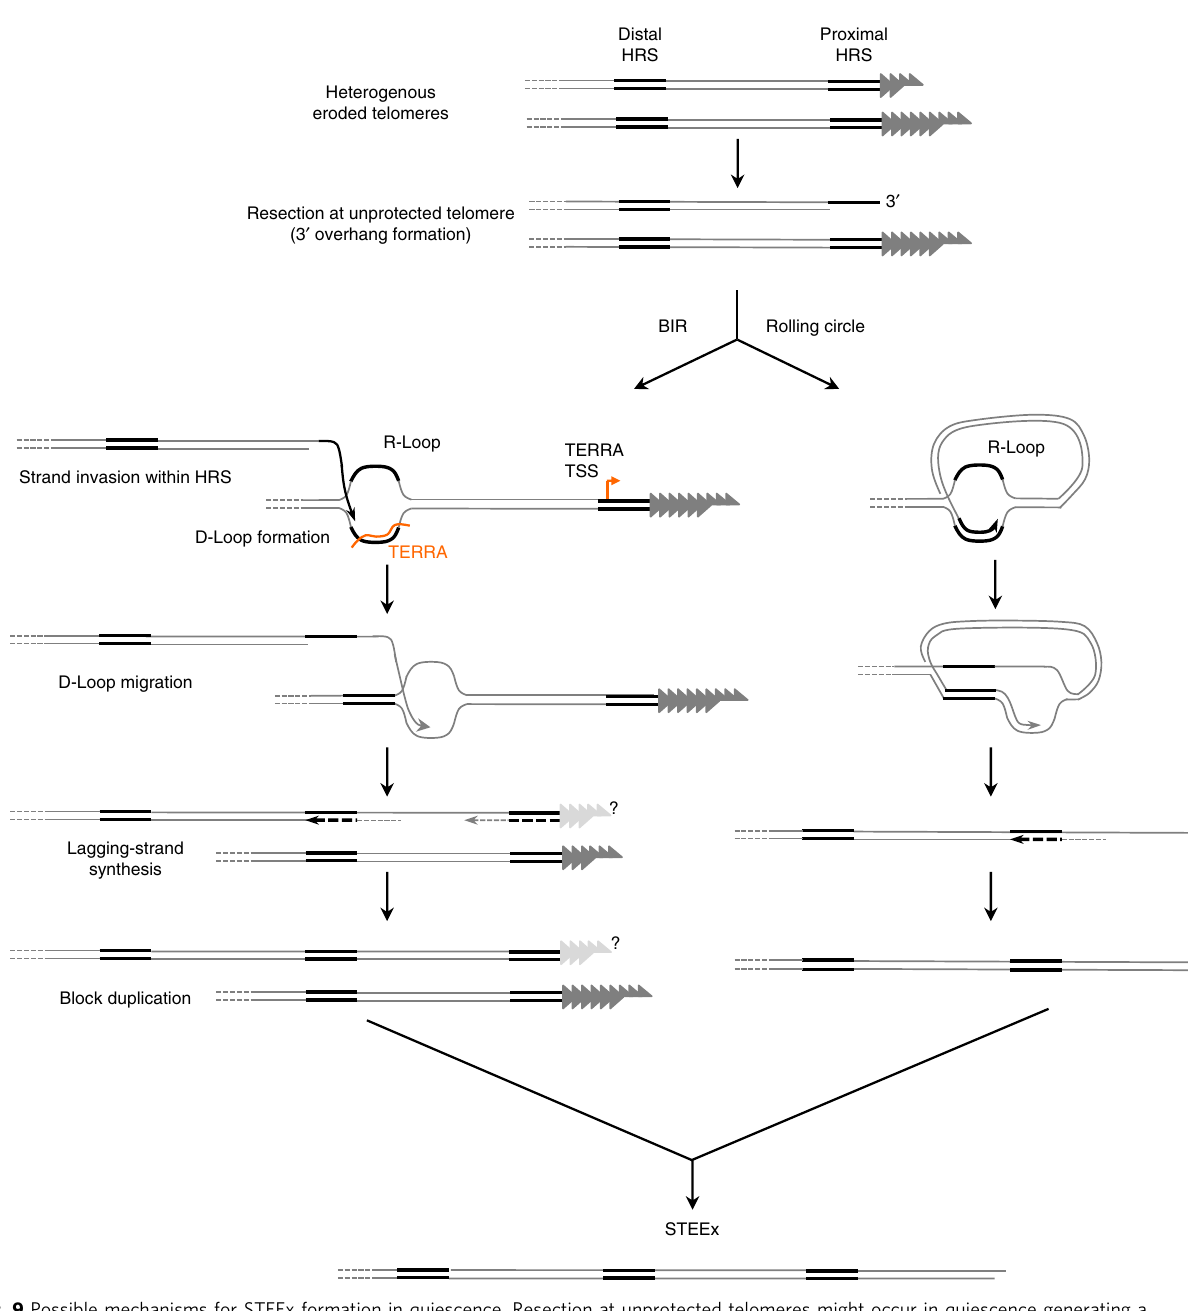
Fig. 9 Possible mechanisms for STEEx formation in quiescence. Resection at unprotected telomeres might occur in quiescence generating a recombinogenic 3 ′ -overhang within the telomere proximal HRS. Homology search and strand invasion by HR machinery might be facilitated by the presence of R-loop within the distal end HRS, thereby forming a D-loop structure. R-loop could be formed in subtelomeric regions by the annealing of TERRA molecules with the distal HRS. Another possibility to generate R-loop would be that RNAs are transcribed from the distal HRS that also contains the TSS sequence. Rad51-mediated HR might occur either internally within the same telomere through a rolling-circle like mechanism, or with another chromosome extremity followed by break induced repair (BIR) related process. D-loop migration and lagging-strand synthesis might then ensure duplication of subtelomeric block. Ampli fi cation of this process might lead to STEEx formation. It is not established if STEEx extremities contain telomeric repeated